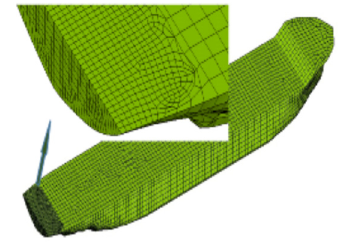
Figure 4. The gridding of ships.